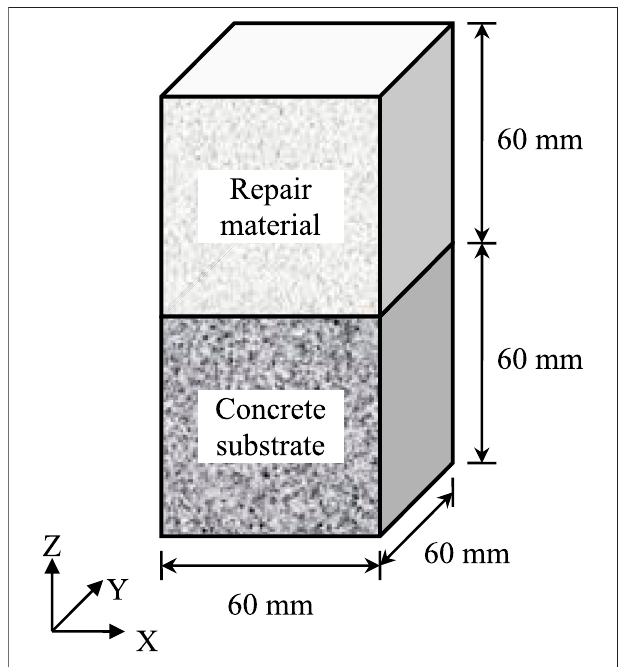
FIGURE 3 | Repair system used in the numerical